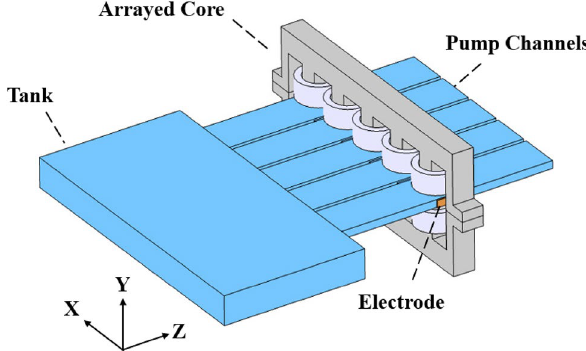
Fig. 5 The schematic of the pump modeled in COMSOL